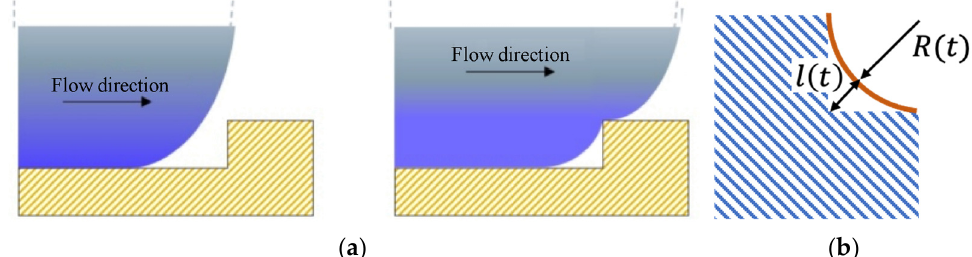
Figure 2. Schematic representation of the microstructure filling that occurs while the advancement of the flow front in the cavity proceeds ( a ). Geometrical representation of the polymer flow front during the microstructure filling ( b ).